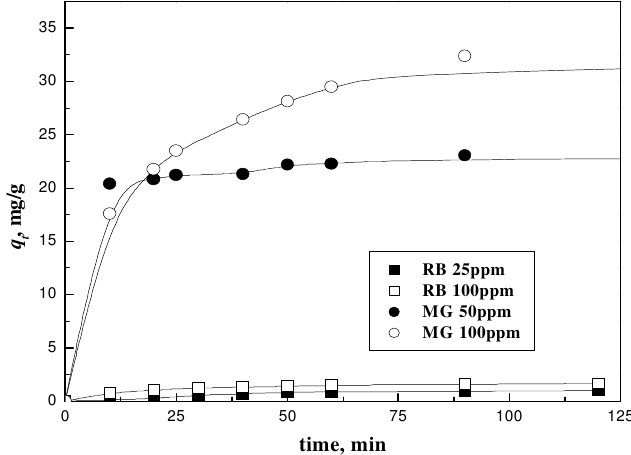
Figure 3. Kinetic curves for the adsorption of dyes on TFC